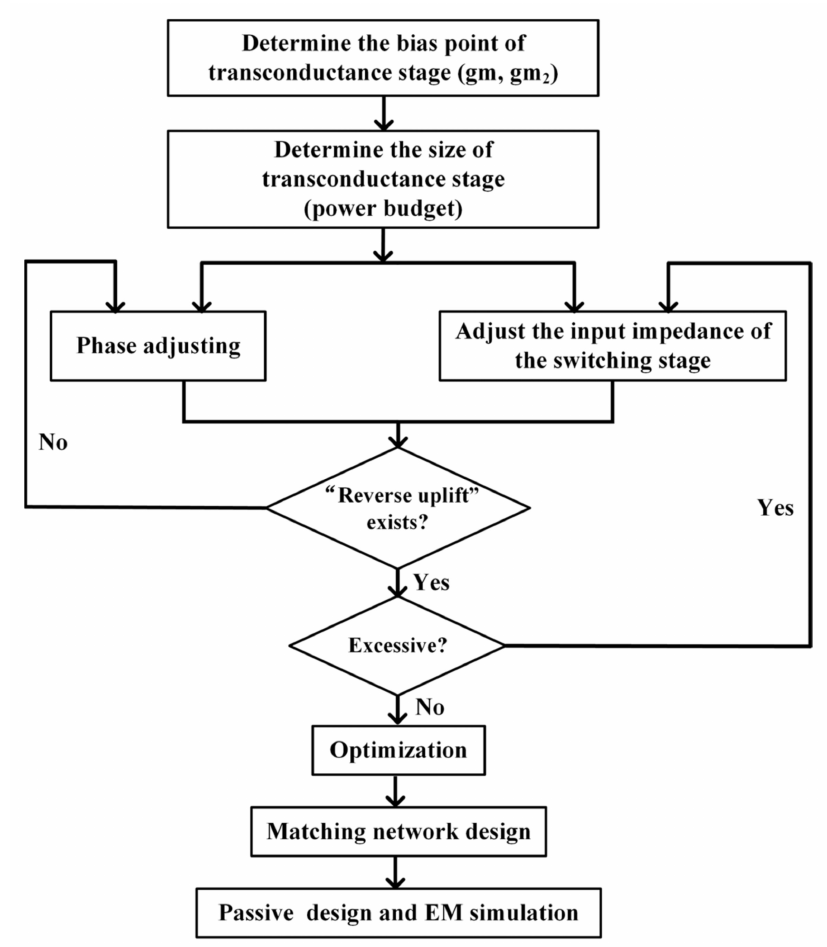
Figure 8. Design process of “reverse